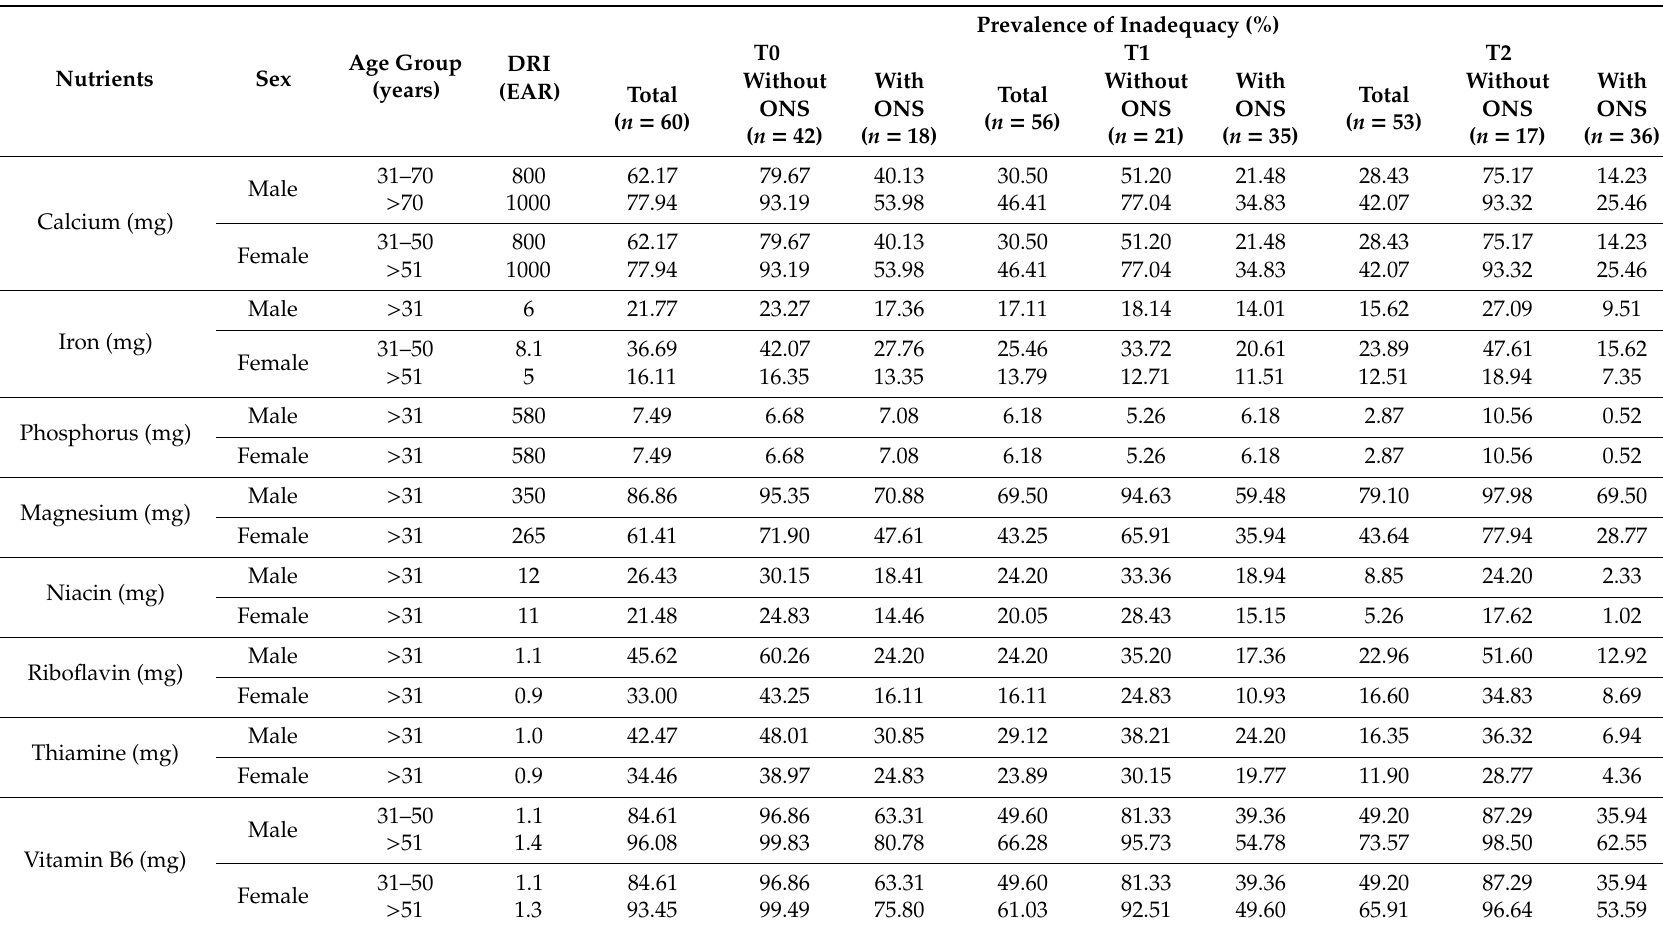
Table 4. Prevalence of nutrient intake inadequacy using the estimated average requirement (EAR) method as the cut-o ff point, and comparison of intake with adequate intake (AI) in head and neck cancer patients during (chemo)radiotherapy.